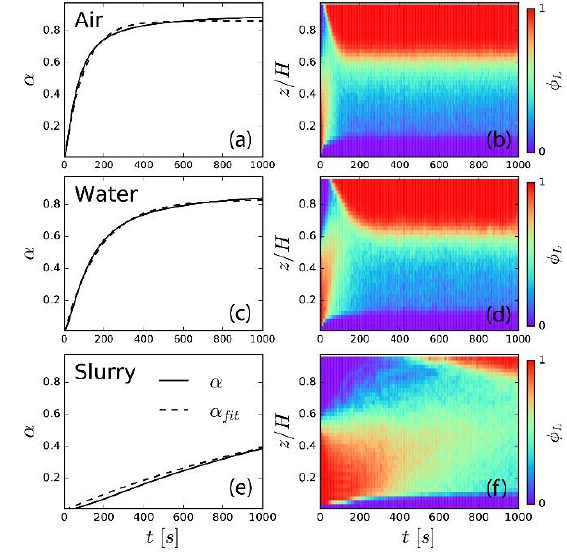
Fig. 2. The temporal evolution of the segregation degree 𝛼 of a mixture flowing in (a) air, (c) water, and (d) viscous slurry and the corresponding spatial-temporal profile of the large particle concentration (b, d, f).